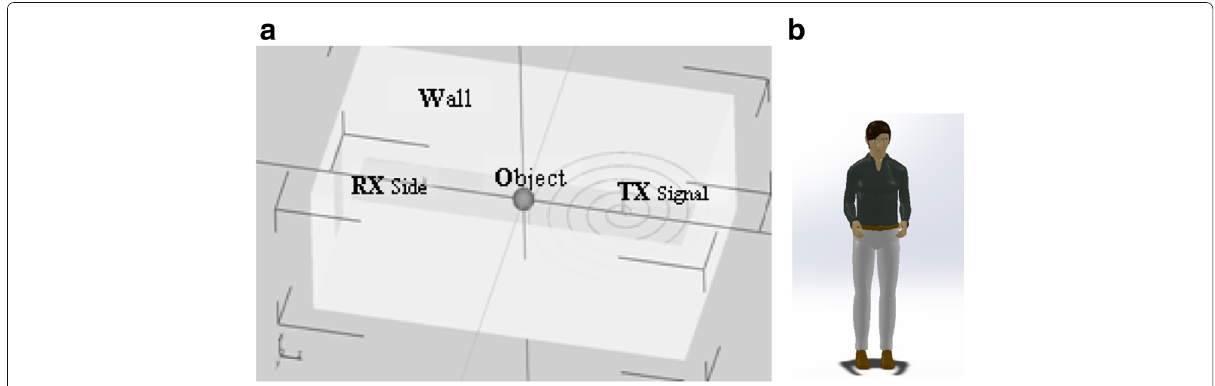
Fig. 5 FDTD interior scenario settings. a recognize scenario; b 3D human body model